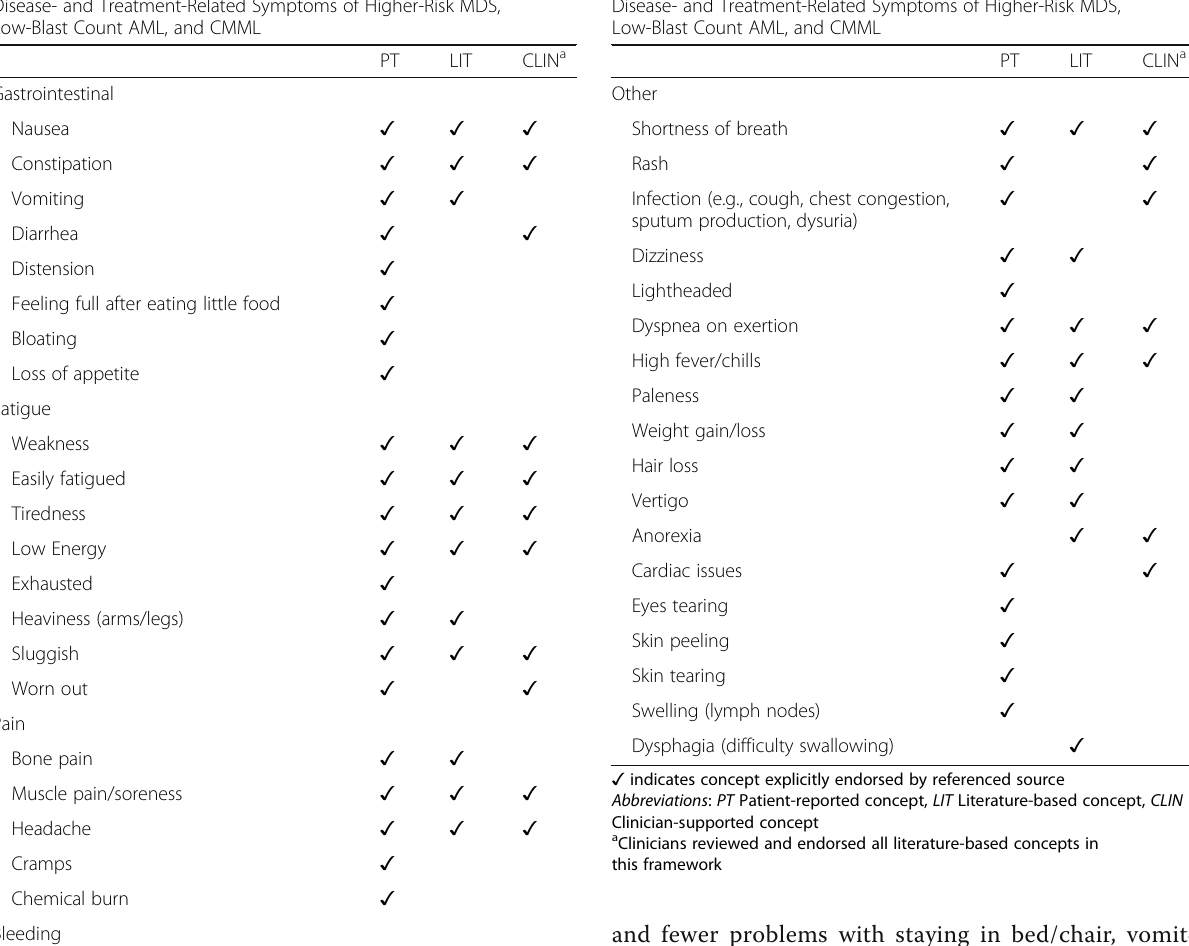
Table 2 Consolidated symptom conceptualization of patient experience with MDS, AML and CMML